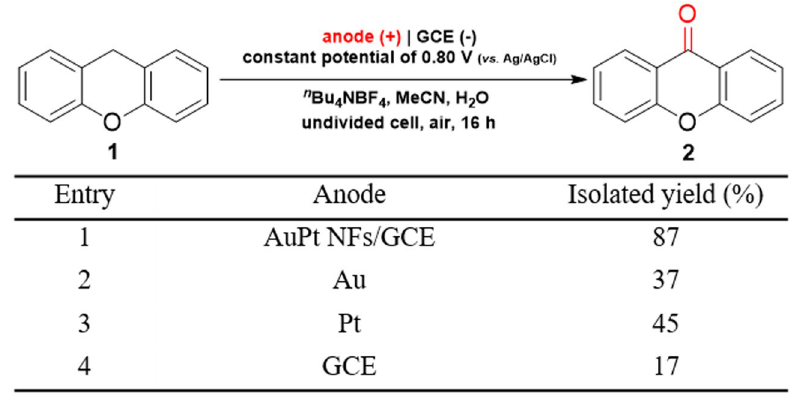
Figure 9. Comparison of the electrochemical performance of various anodes. Reaction conditions: 1 (0.3 mmol), n Bu